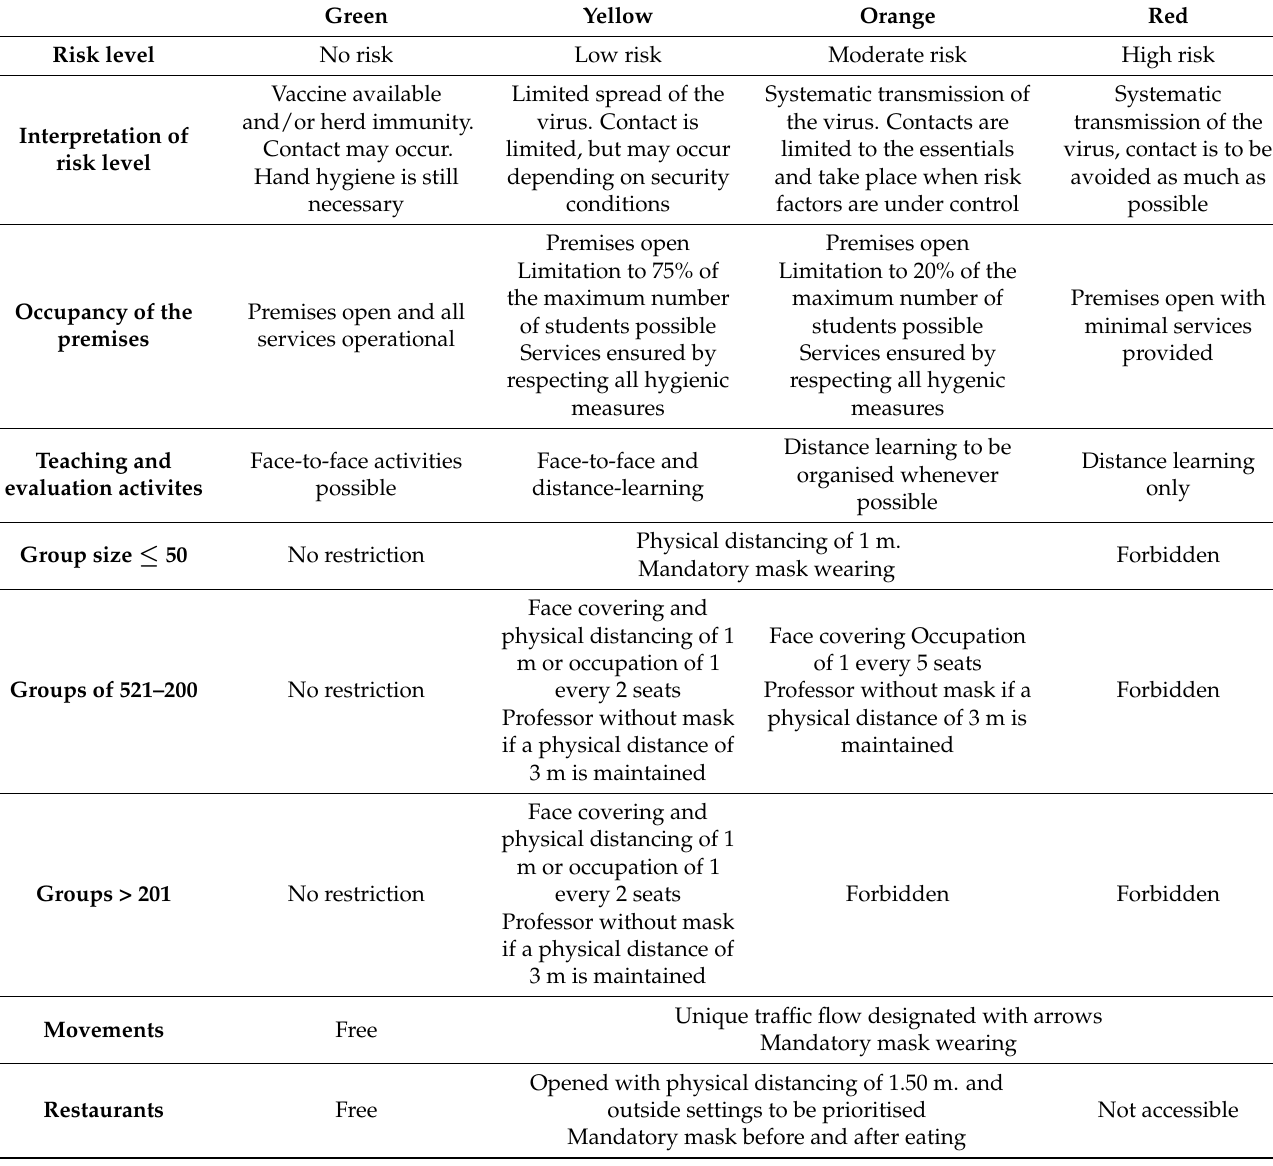
Table A1. Colour codes in universities depending on the risk level regarding